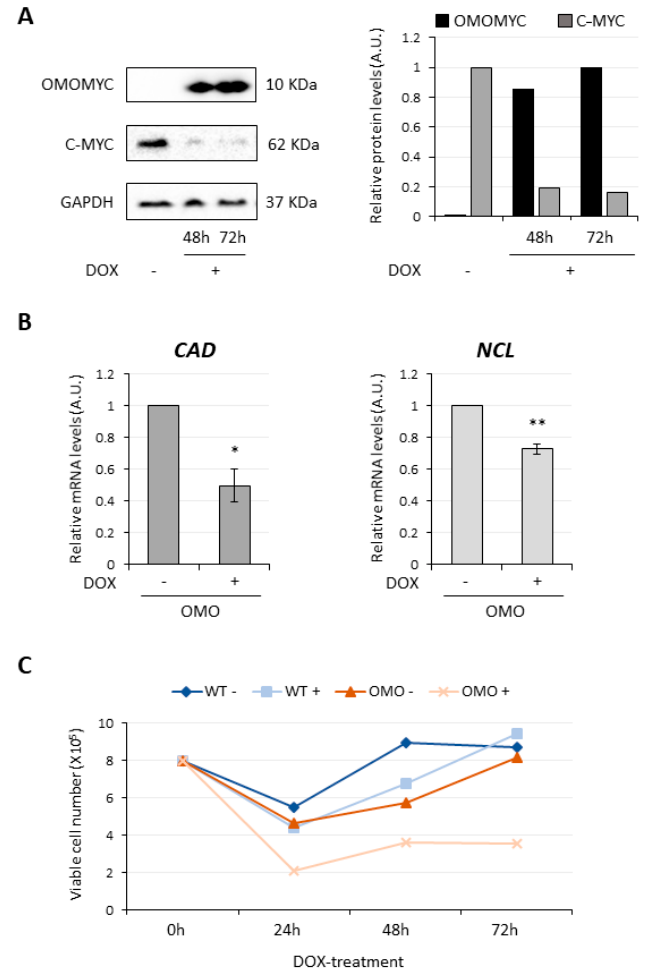
Figure 1. OMOMYC inhibits MYC expression and function in D283 MED cells. Details in Figure S2. ( A ) Left panel: immunoblot analysis of OMOMYC and MYC proteins in DOX-untreated (lane − ) or treated (lanes +) D283–OMO cells; GAPDH was used as control. Right panel: quantification of OMOMYC (black bars) and MYC (grey bars) protein levels expressed in arbitrary units (A.U.) relative to GAPDH. N = 1 . Timing of DOX treatment (hours) is reported below each lane and each corresponding histogram bar. ( B ) qRT-PCR analysis of CAD (left panel) and NCL (right panel) gene expression upon 72h-OMOMYC induction by DOX-treatment (+) in D283-OMO cells. Untreated cells ( − ) were used as control and set as 1. Data (means ± SEM) are expressed in arbitrary units (A.U.) and are relative to ATP5O mRNA levels. N = 3, * p ≤ 0.05, ** p ≤ 0.01 (two-tailed Student’s t -test). ( C ) Analysis of the number of viable cells in D283-OMO (OMO) and D283-WT lines (WT), untreated ( − ) or treated (+) with DOX for 0, 24, 48 and 72 h. Viable cells were counted using an automated cell counter. N =